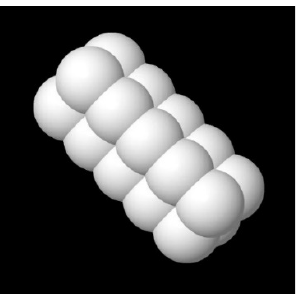
Figure 3. Model of the microrod as a group of bonded particles linked through elastic